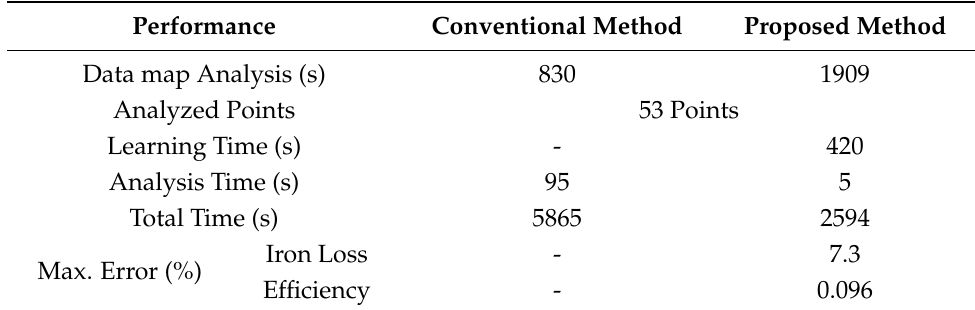
Table 4. Comparison of Results.